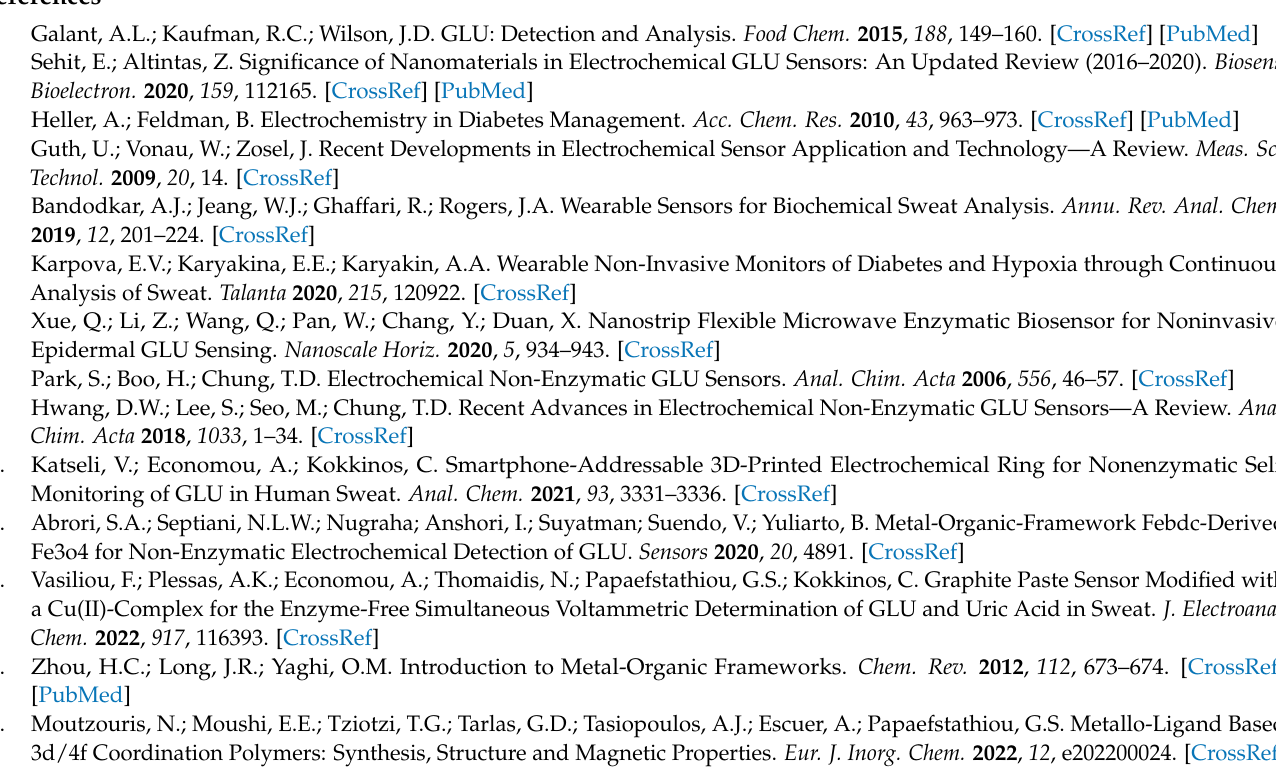
Figure S12: Representative chromatogram of (a) standard GLU solution (20 mg L − 1 ) ( b ) supernatant solution of artificial sweat using as absorbent the 2D-Fe-MOF (where GLU (Q) is the quantifier ion of GLU, GLU (q) is the qualifier ion of GLU, and GLU- 13 C (IS) is the most abundant ion for the internal standard GLU- 13 C; Figure S13: The asymmetric unit of the 3D-Fe-MOF . Color code: Fe orange, C, grey, H cyan, O red, N blue; Figure S14: The coordination environment around Fe1 (left) and Fe2 (right) in the crystal structure of the 3D-Fe-MOF . Color code: same as in Figure S13; Figure S15: The coordination mode of the tetra-anion of the ligand (H 2 L 4 − ) in the crystal structure of the 3D-Fe-MOF . Color code: same as in Figure S13; Figure S16: The asymmetric unit of the 2D-Fe-MOF . Color code: Fe orange, C, grey, H cyan, O red, N blue; Figure S17: The coordination environment around Fe (left) and the coordination mode of the di-anion of the ligand (H 4 L 2 − ) (right) in the crystal structure of the 2D-Fe-MOF . Color code: same as in Figure S16; Figure S18: The underline sql network of the 2D-Fe-MOF . Color code: same as in Figure S13; Figure S19: DP voltammograms of 0 and 600 µ M GLU at the GPE modified with the 3D-Fe-MOF in artificial sweat (pH